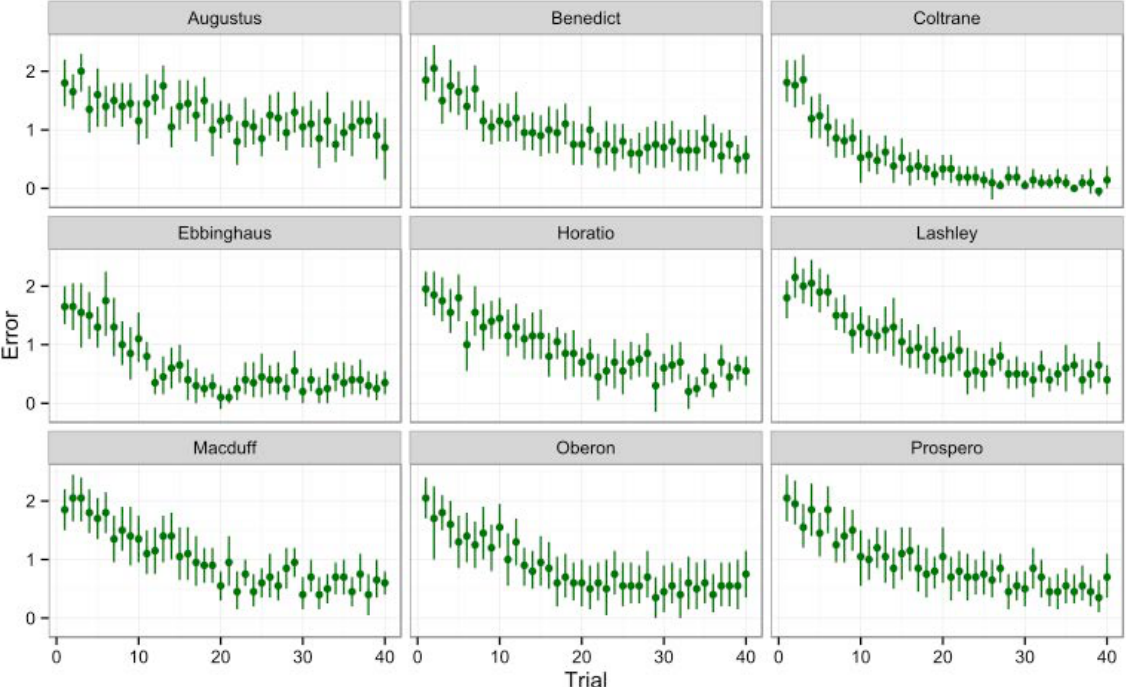
Figure 2. Average Error data from 20 sessions of 40 trial SimChain, from 9 monkeys. Bars indicate standard errors.